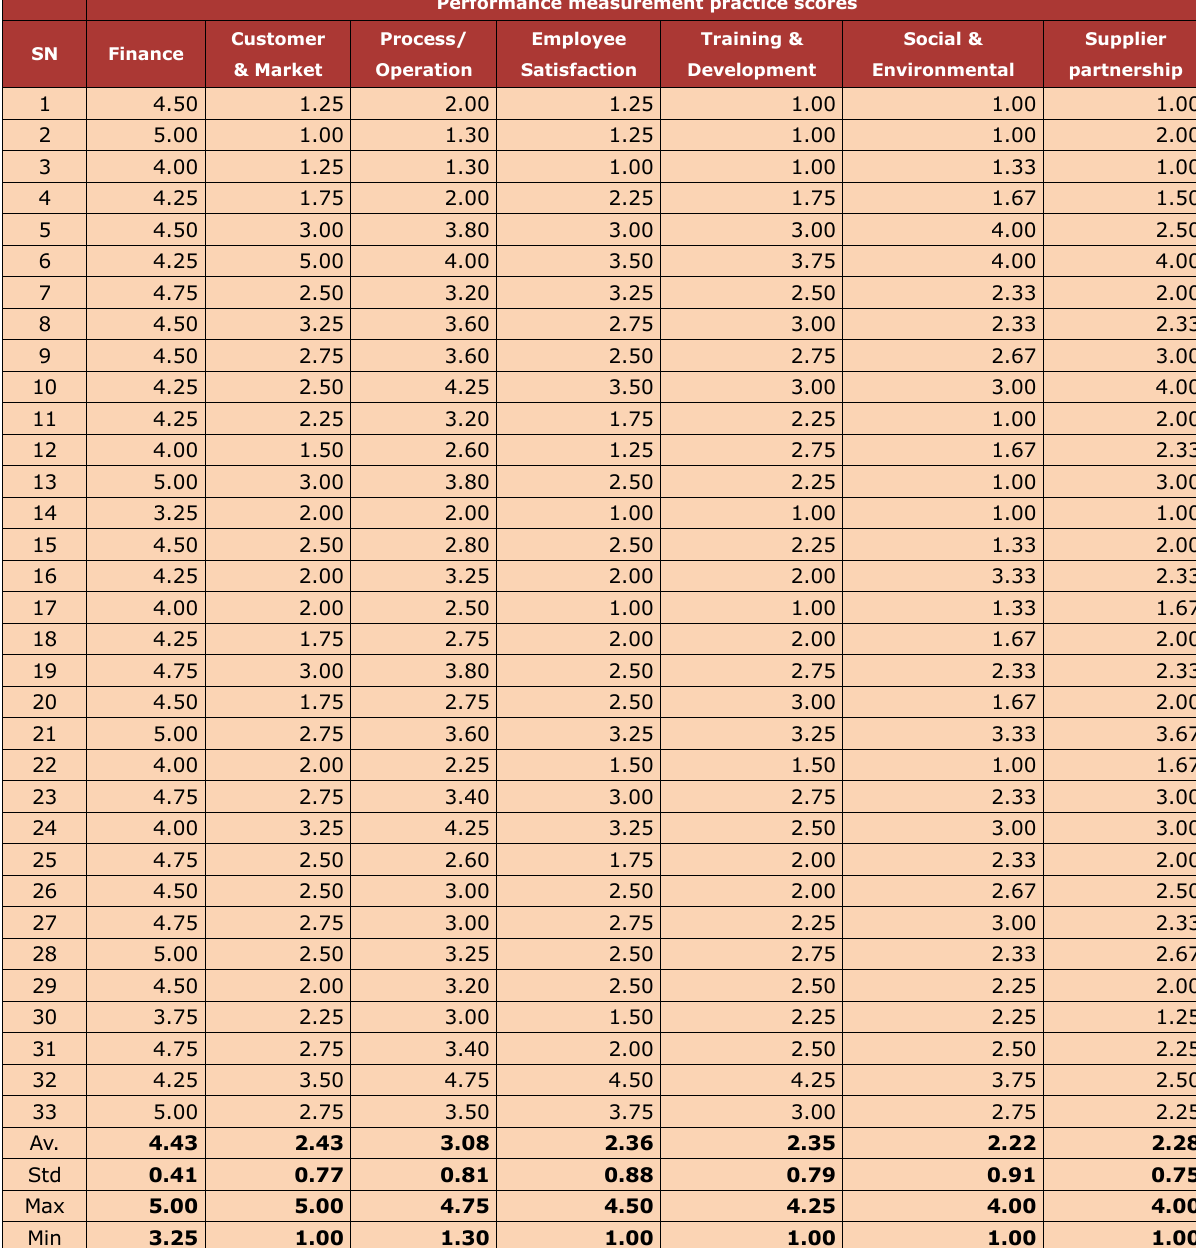
Table 8. Financial and non-financial performance measures